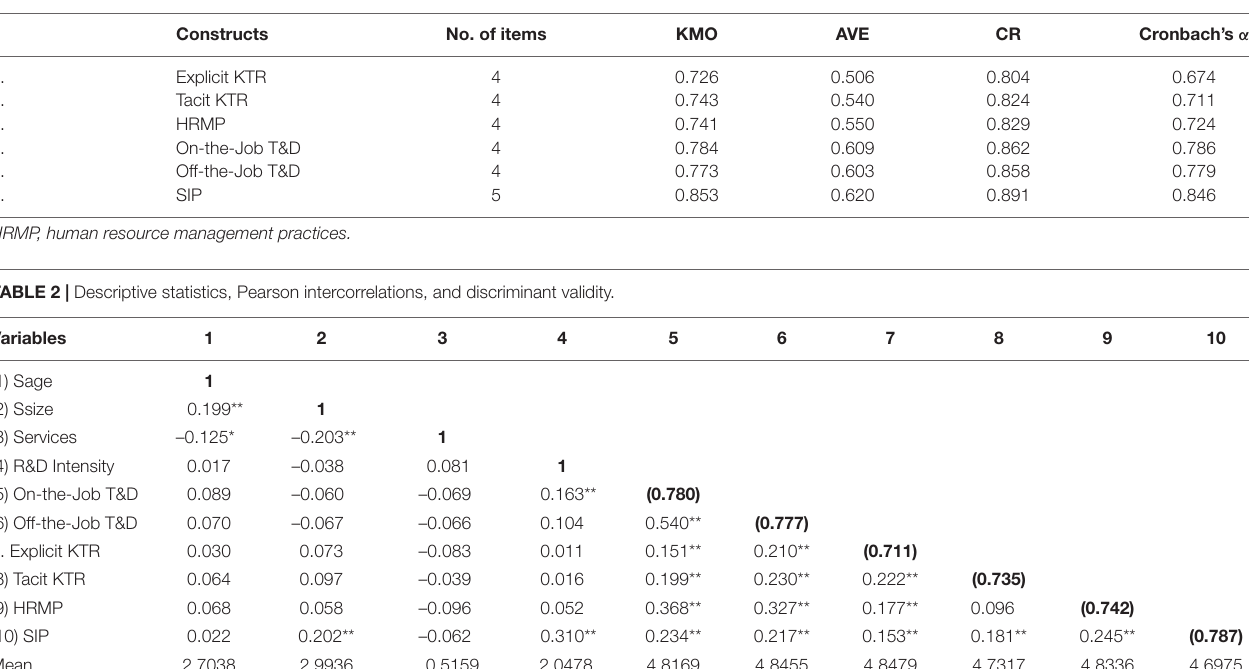
TABLE 1 | Measurement test.